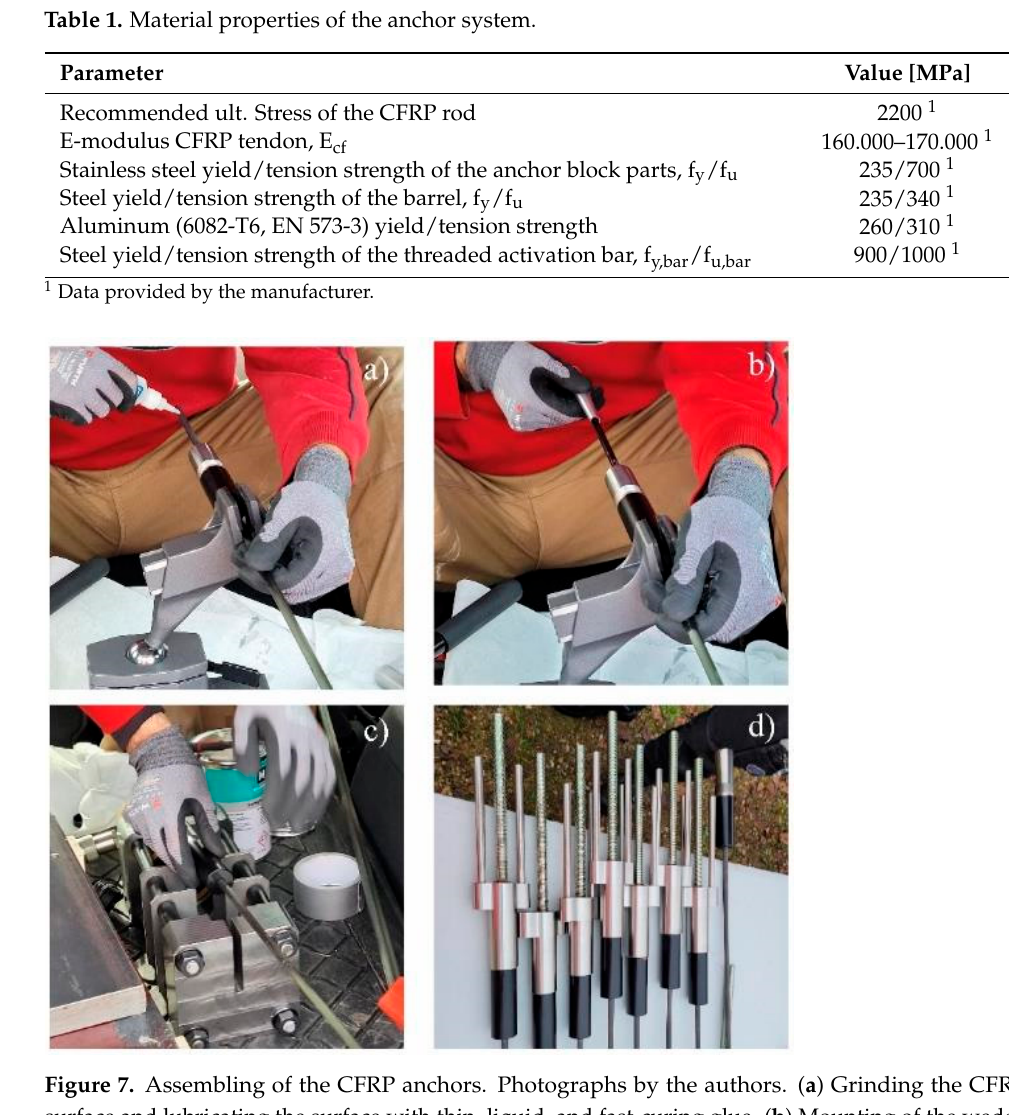
Figure 6. Anchor system parts. Table 1. Material properties of the anchor system.